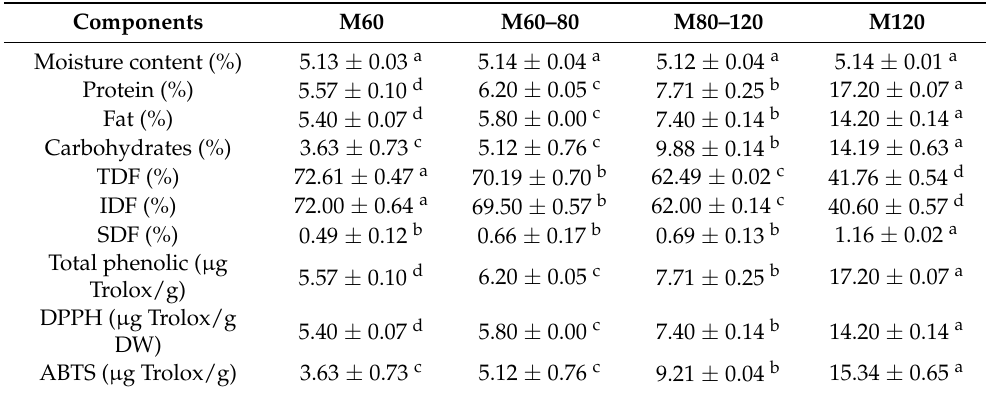
Table 2. The nutritional characteristics and antioxidant activity of the foxtail millet bran powder. Components